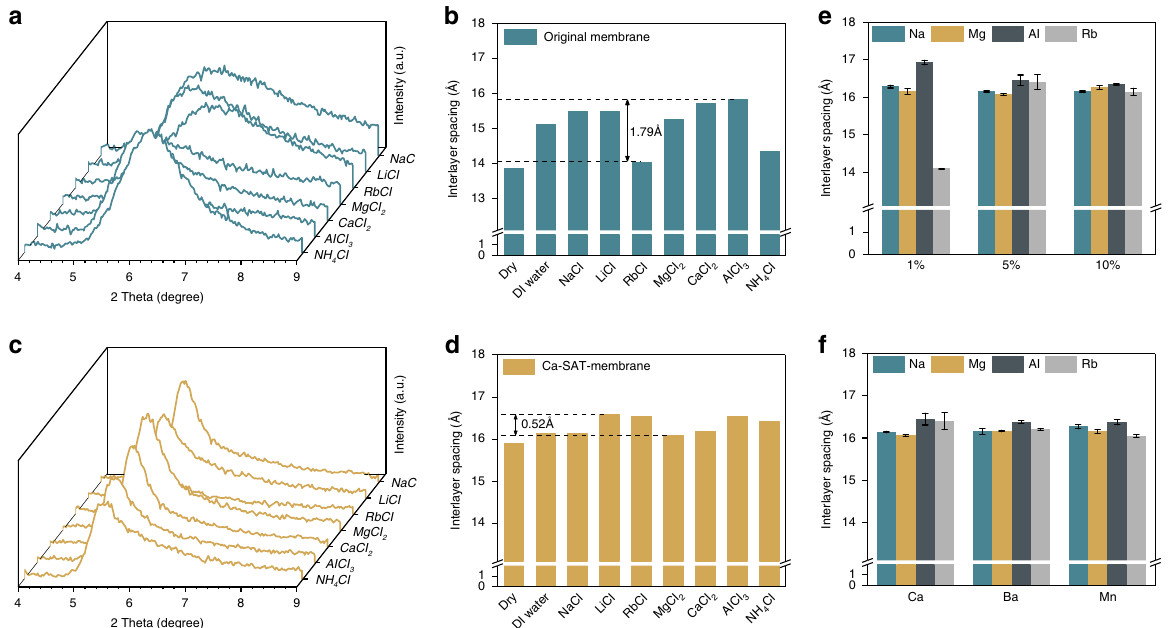
Fig. 3 Interlayer spacings of original and pillared Ti 3 C 2 T x membranes. a , b Interlayer spacings of the original membrane immersed in pure water or in various 0.5 mol L − 1 salt solutions, as shown by the XRD pattern and bar chart. c , d Interlayer spacings of the Ca-SAT membrane immersed in pure water or in various 0.5 mol L − 1 salt solutions, as shown in the bar chart and XRD pattern. e Interlayer spacings of the SA-Ti 3 C 2 T x membrane cross-linked by Ca 2 + with different amounts of sodium alginate (1%, 5%, and 10%). f Interlayer spacings of the SA-Ti 3 C 2 T x membrane cross-linked by Ca 2 + , Ba 2 + , and Mn 2 + immersed in various salt solutions. The error bars represent the standard deviations of three parallel tests.